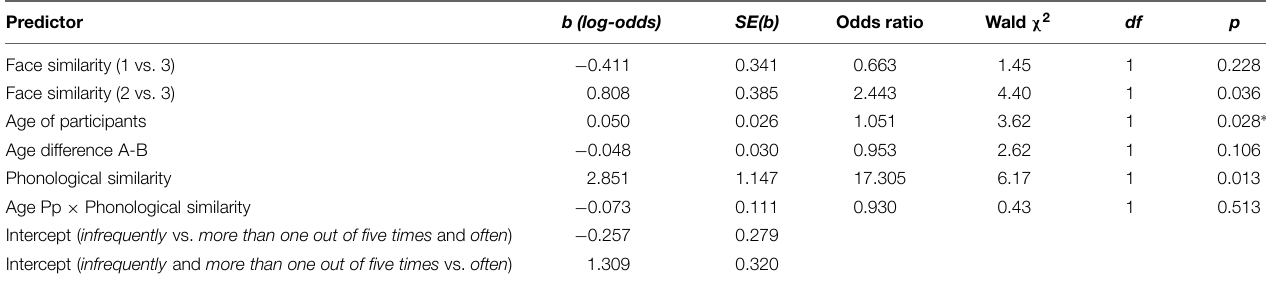
TABLE 1 | Parameters for the estimated cumulative ordinal regression model for error frequency. Predictor b (log-odds) SE(b) Odds ratio Wald χ 2 df p Face similarity (1 vs. 3) Face similarity (2 vs.